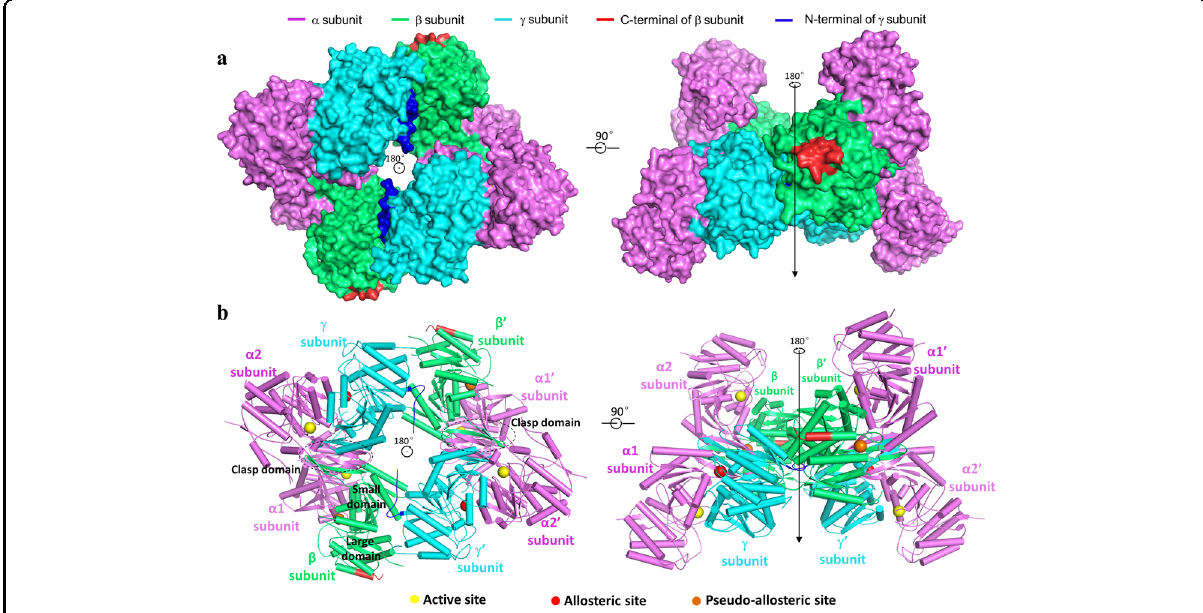
Fig. 1 Overall structure of the apo β -mutant HsIDH3. a Surface and b cartoon presentations of the apo β -mutant HsIDH3 in two different orientations. Left: view along the crystallographic 2-fold axis of the heterooctamer of HsIDH3. Right: view in perpendicular to the crystallographic 2- fold axis of the heterooctamer of HsIDH3. The color coding of the α , β , and γ subunits is shown above. The N-terminal regions of the γ subunits and the C-terminal substituted regions of the β subunits are colored in blue and red, respectively. The clasp domains of the αβ and αγ heterodimers are indicated with dashed ovals. The active sites, the allosteric sites, and the pseudo allosteric sites are indicated with yellow, red, and orange spheres, respectively. Residues and structure elements of the α and β subunits of the αβ heterodimer and the α and γ subunits of the αγ heterodimer are superscripted by “ A1 ” and “ B ” , and “ A2 ” and “ G ” ,